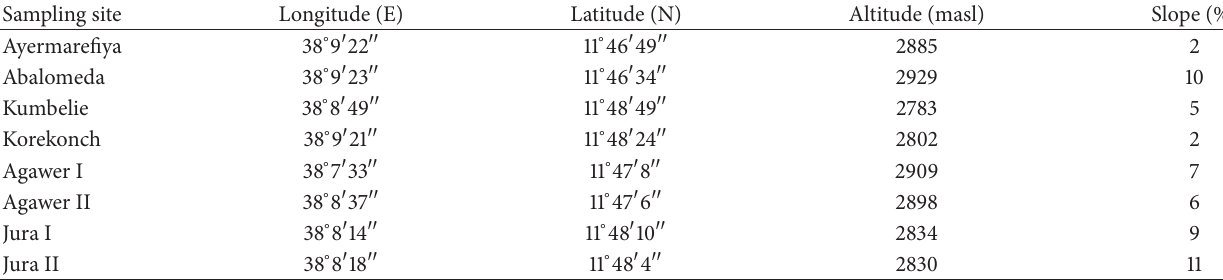
Table 1: Sampling locations and site description.